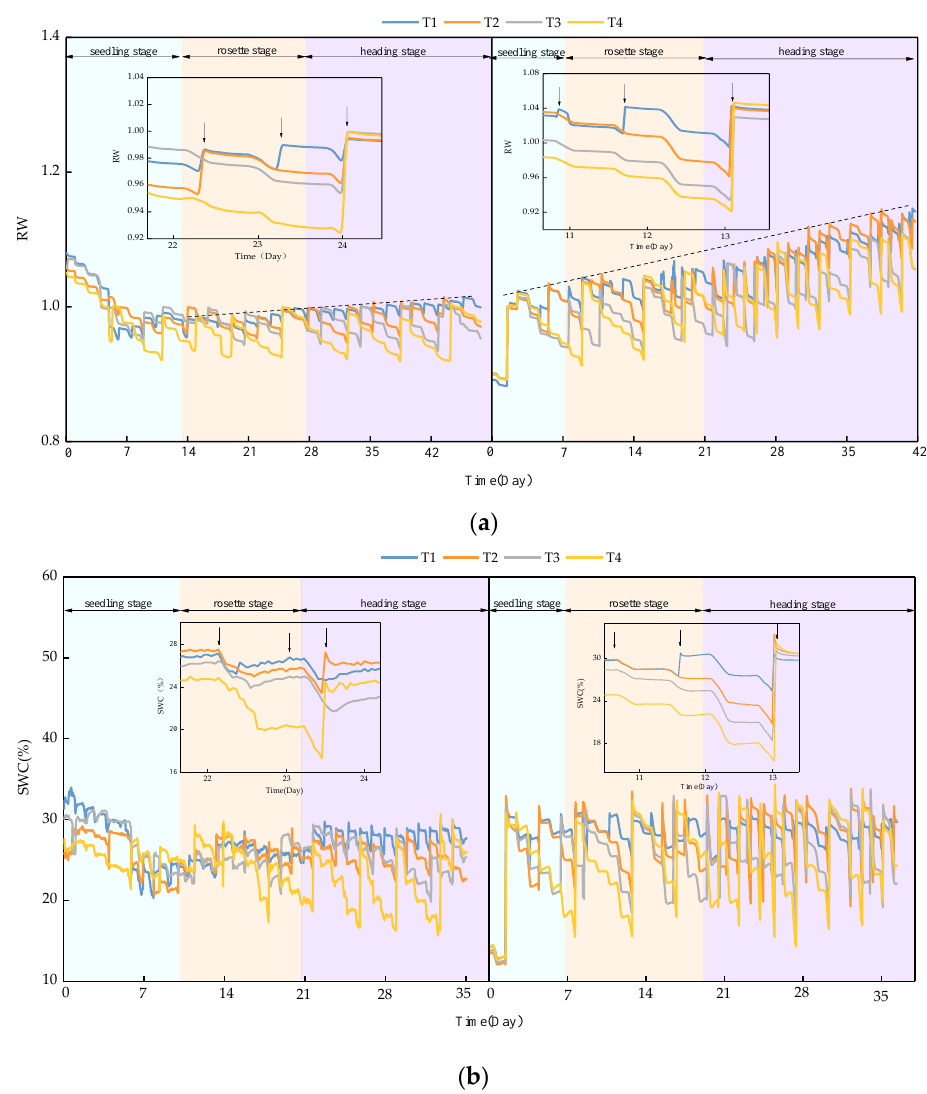
Figure 5. Changes of RW and SWC under different water treatments ( a ) RW change of lettuce in the first and second seasons under different water treatments, ( b ) SWC change under different water treatments in the first and second seasons.